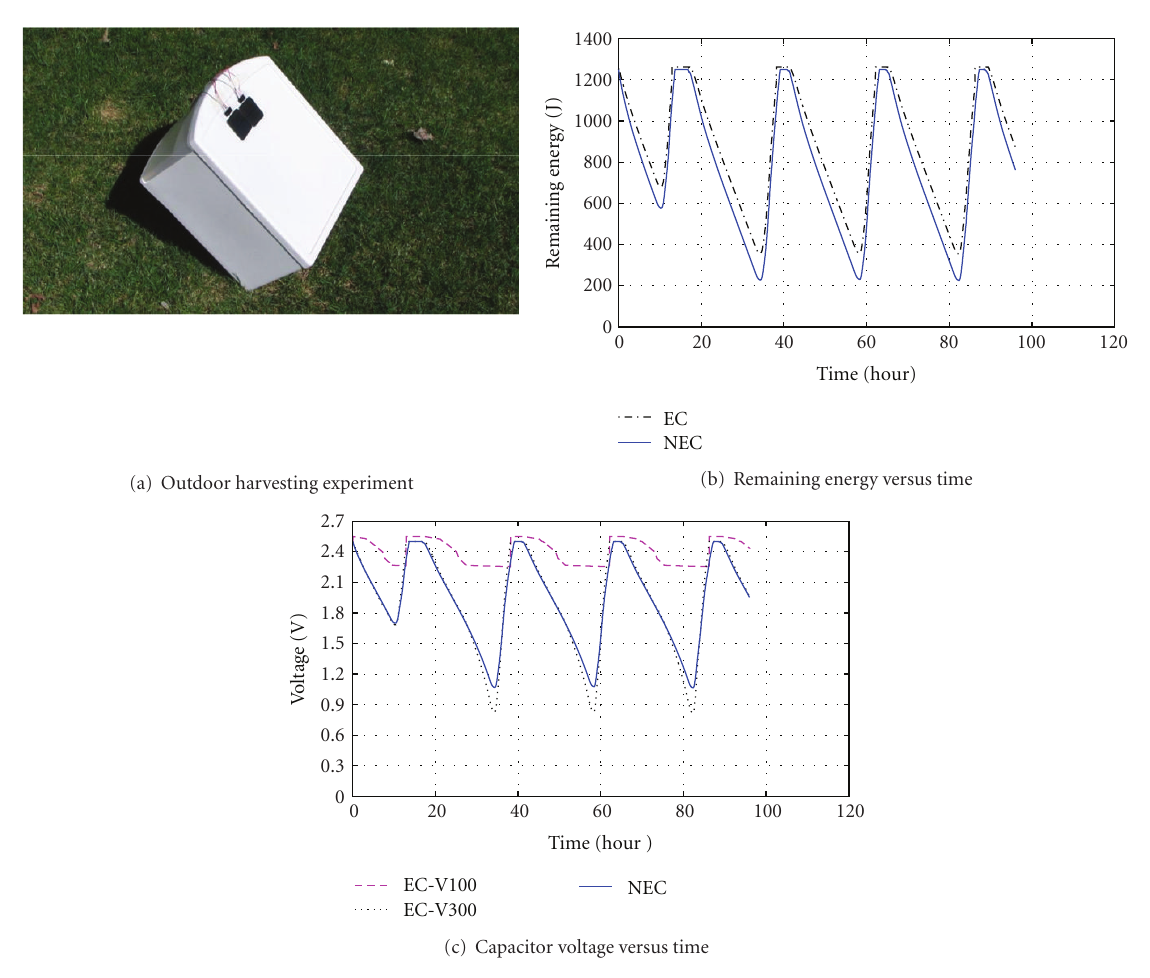
Figure 11: Outdoor energy harvesting.